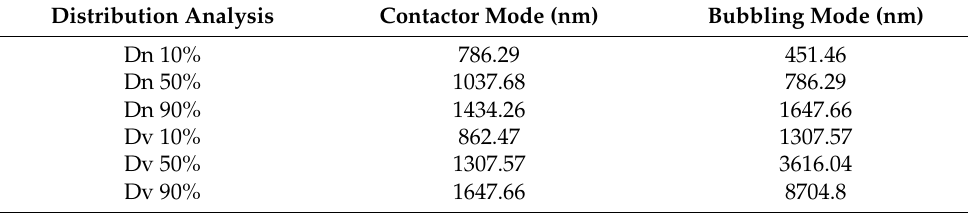
Table 4. Number-based diameter parameters (Dn 10%, 50%, 90%) and volume-based diameter parameters (Dv 10%, 50%, 90%) of samples in contactor and bubbling